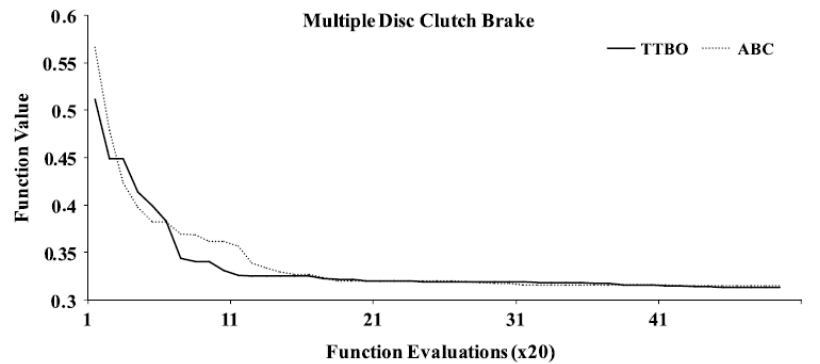
Figure 4: Convergence plots for the Multiple Disc Clutch Brake using the TLBO and ABC algorithms (Rao et al.,